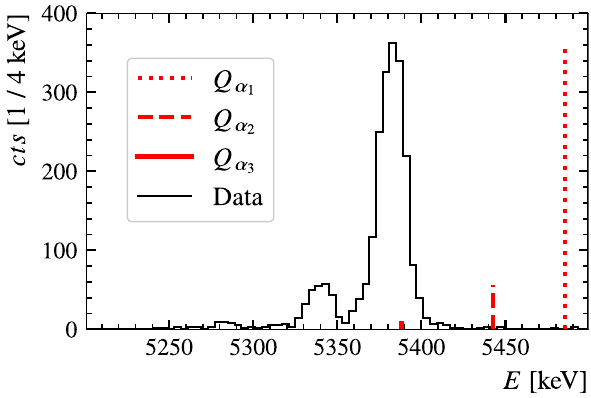
Fig. 2 Q values (vertical lines) and measured alpha energy spectrum (histogram) in response to 241 Am irradiation onto the side of the Super- Siegfried detectorfor one hour. The height of the verticallines represent the branching ratio of the respective